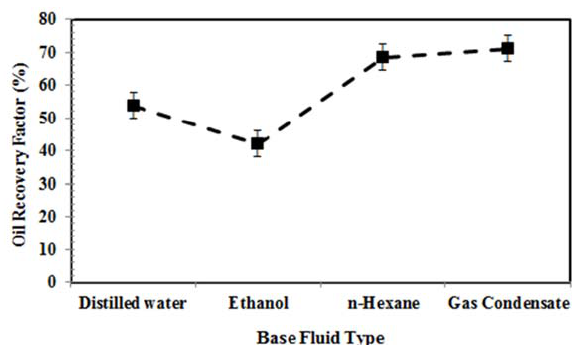
Fig. 15. Effect of the base fluid type on the oil recovery